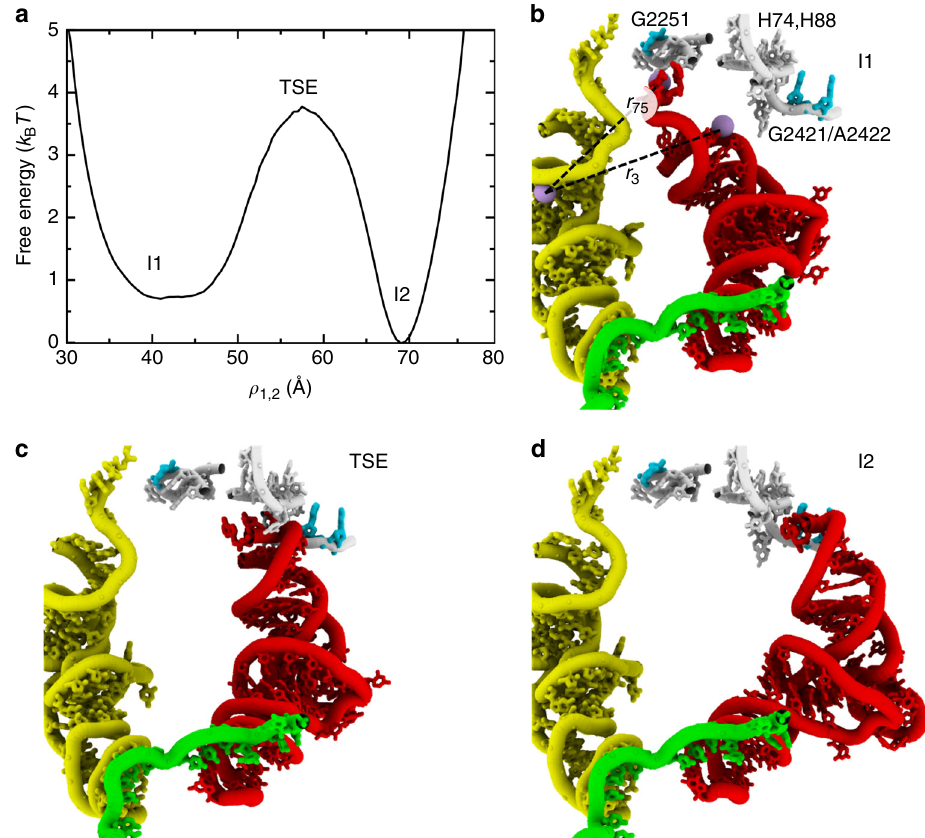
Fig. 4 Identifying the rate-limiting free-energy barrier. a Since the I1 – I2 transition is rate-limiting in the simulations (Supplementary Table 1), we calculated the free-energy as a function of the tRNA position for this step. To speci fi cally describe the I1 – I2 transition, the free energy was calculated for simulated frames that were within these ensembles and the associated transition state ensemble (TSE). The I1 – TSE – I2 con fi guration space was de fi ned as 12 Å < R P < 42 Å and 15 Å < R E < 50 Å . The coordinate ρ 1,2 was used for analysis, after applying transition path analysis to thousands of possible tRNA coordinates. ρ 1,2 is de fi ned as a linear combination of two interatomic distances that monitor the 3 ′ -CCA end ( r 75 ) and the acceptor arm ( r 3 ). r i is the distance between O3 ′ atoms of residue i of the P-site tRNA and residue 67 of the A-site tRNA. b Structural snapshot of the I1 ensemble ( ρ 1,2 ~ 40 Å ), rotated relative to Fig. 2. c Representative snapshot of the transition-state ensemble ( ρ 1,2 ~ 57 Å ). Visual inspection would suggest the TSE is characterized by close interactions between the tRNA and H74/H88. d Representative I2 con fi guration ( ρ 1,2 ~ 70 Å